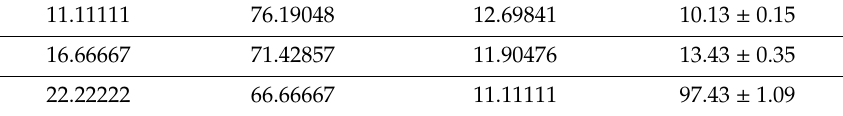
Diagram 8: Octanoic acid, Tween 20 ® , and Transcutol HP ® at a Smix ratio of